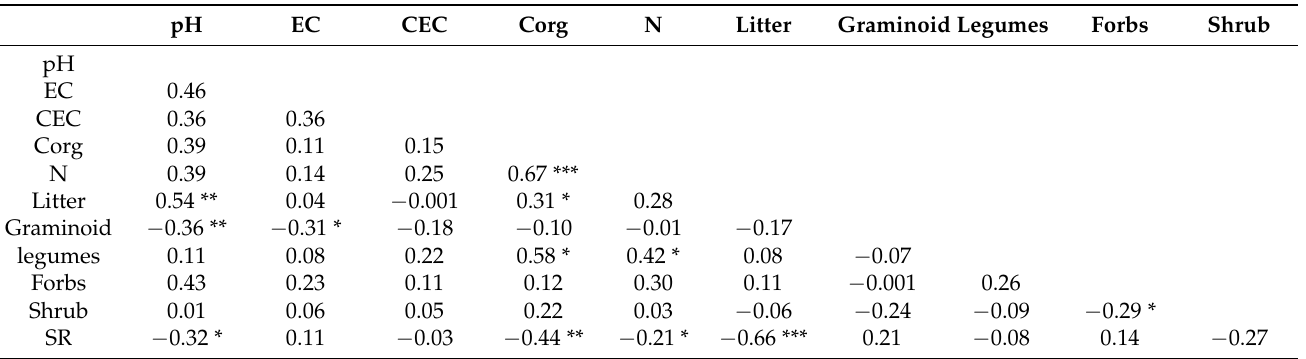
Table 4. Pearson correlation between the soil properties and vegetation data (PFTs biomass and species richness). Coefficients of correlation in bold are significant for p ≤ 0.05 (*), p < 0.01 (**)